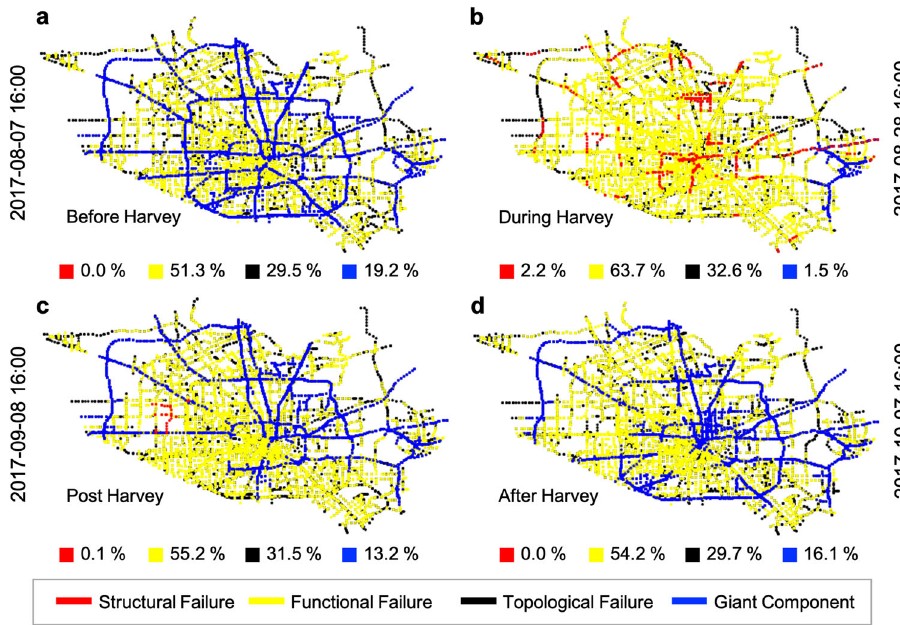
Fig. 5 Spatial distribution of network failures in the afternoons with threshold q = 0.8. The same weekday (Monday) and time (16:00) are selected for the illustration. a Transportation network before Harvey in which functional failure (yellow line) is the leading cause of network connectivity loss. b When Hurricane Harvey landed, fl ooding (i.e., structural failure in red line) exacerbated the functional failure (i.e., travel speed reduction) and topological failure (black line), leading to large-scale network fragmentation (i.e., giant component reduction in blue line). c Immediate post-Harvey recovery with part of transportation network remaining fl ooded. d Transportation network long-term recovery after Harvey.